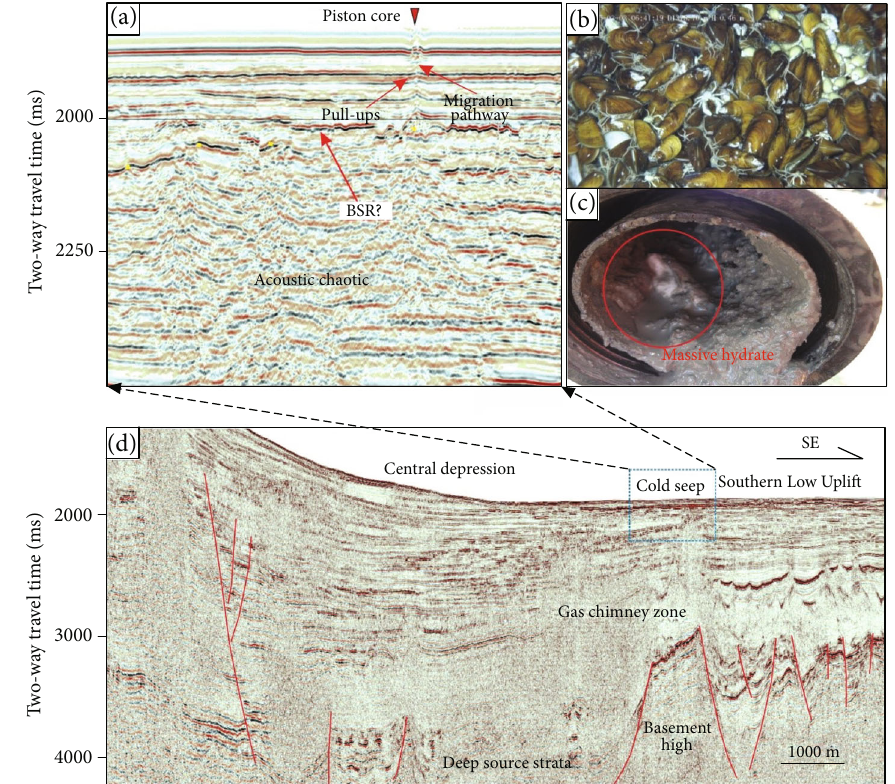
Figure 5: (a) Seismic pro fi le showing the hydrocarbon migration and seepage features in the Haima Cold Seep. (b) Microbial communities and (c) massive gas hydrates recovered from the Haima Cold Seep (modi fi ed from [49]). (d) Seismic pro fi le showing the deep structural features below the Haima Cold Seep in the southern low uplift area of the Qiongdongnan Basin. Large range of acoustic fuzzy zones resulting from gas chimneys can be observed on the seismic pro fi le, indicating the upward migration of deep hydrocarbons, which supply materials for gas seepage and gas hydrate